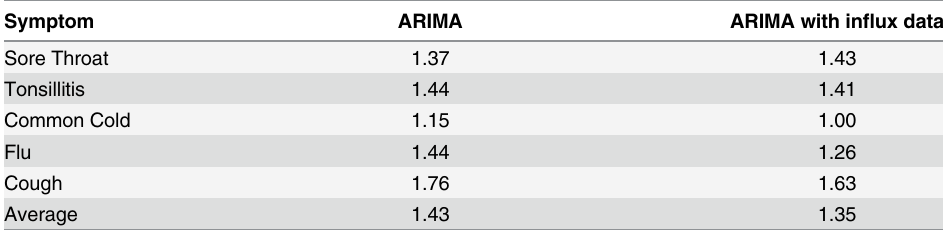
Table 8. Mean of all MAE errors for each symptom, showing both forecasting methods. (4-fold cross-